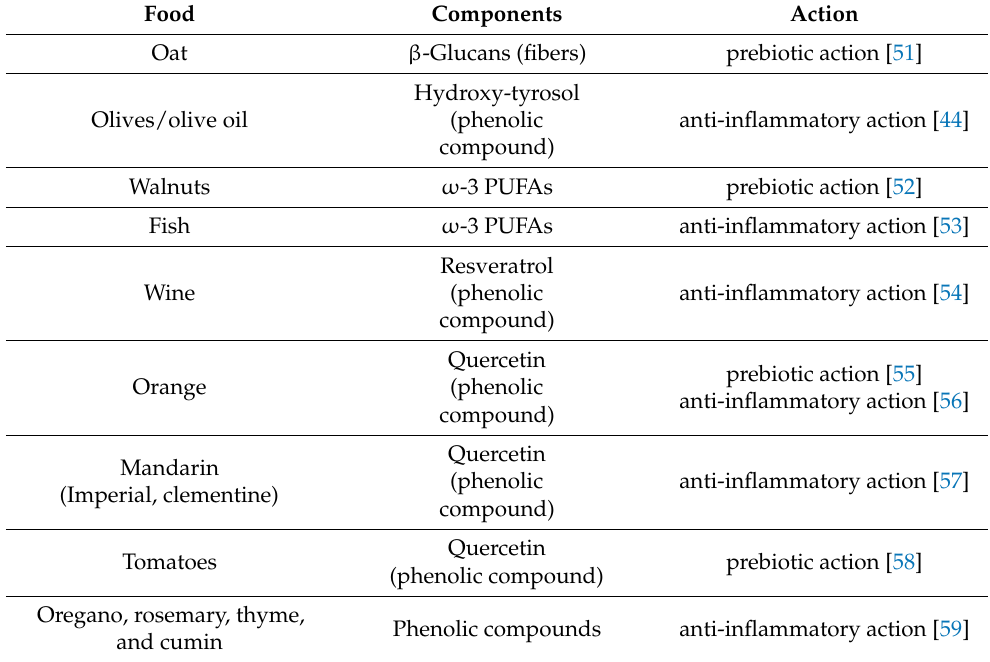
Table 2. Common foods in the MedDiet, free of FODMAPs according to the Monash University